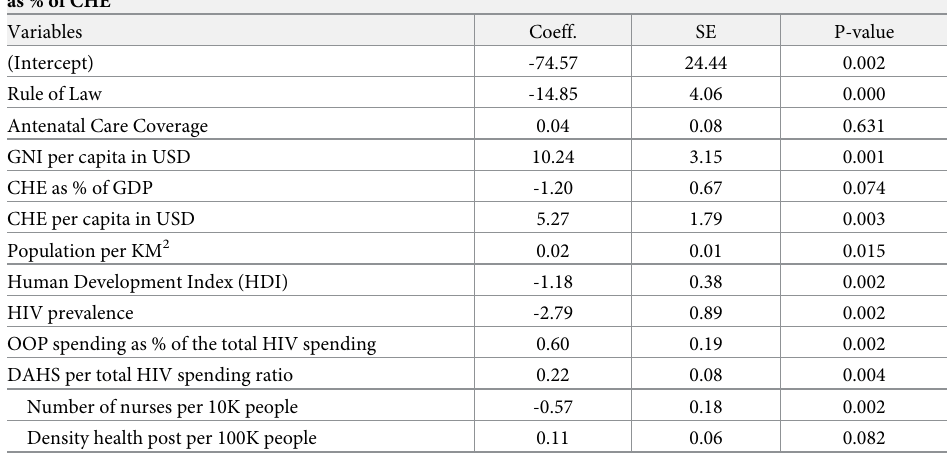
Table 5. Results of the sensitivity analyses for the reciprocal of the efficiency scores (i.e. inefficiency) (N = 78). A) Exploring by number of nurses and density of health posts Variables Coeff.